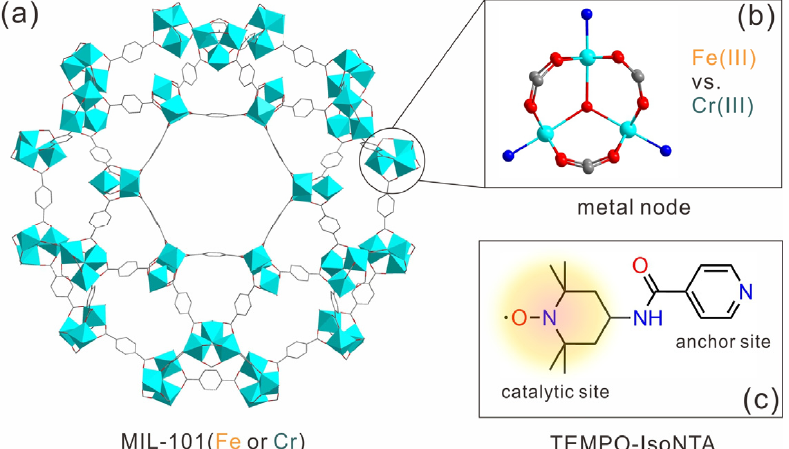
Figure 1. ( a ) Crystal structure of MIL-101(Fe/Cr); ( b ) open metal sites in MIL-101(Fe/Cr); ( c ) molecular structure of the TEMPO-IsoNTA bearing catalytic site and anchoring site. C: grey; O: red; Fe 3+ or Cr 3+ : cyan; N: blue.